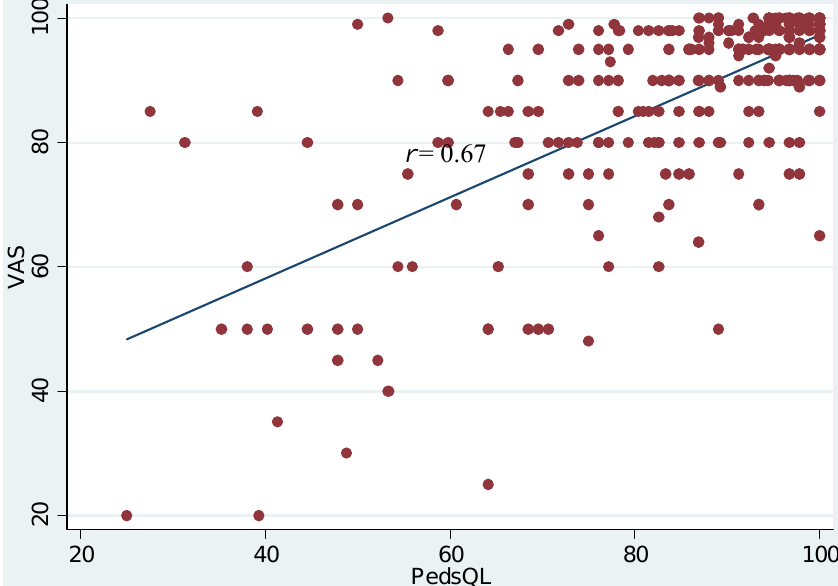
Figure 1. Scatter Plot and Fitted Line of VAS over PedsQL TM